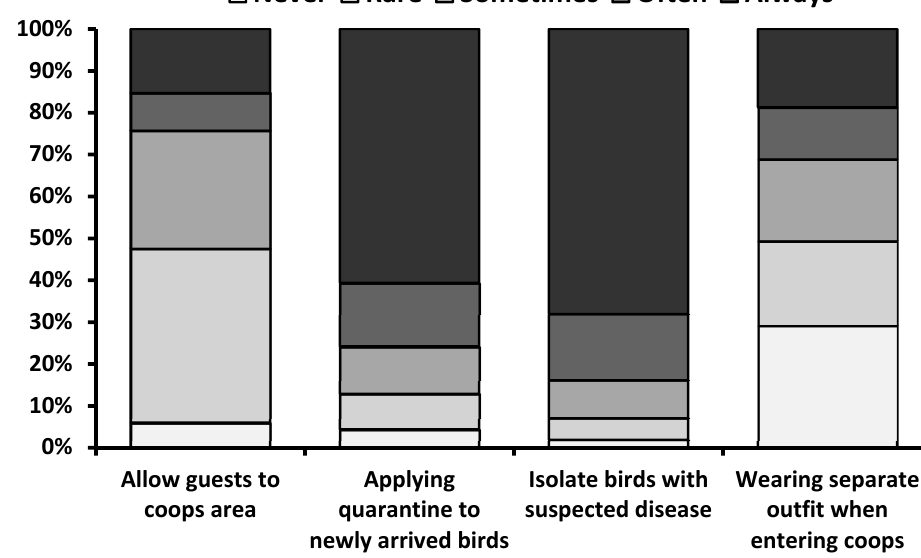
Figure 4. Biosecurity awareness of the survey respondents.